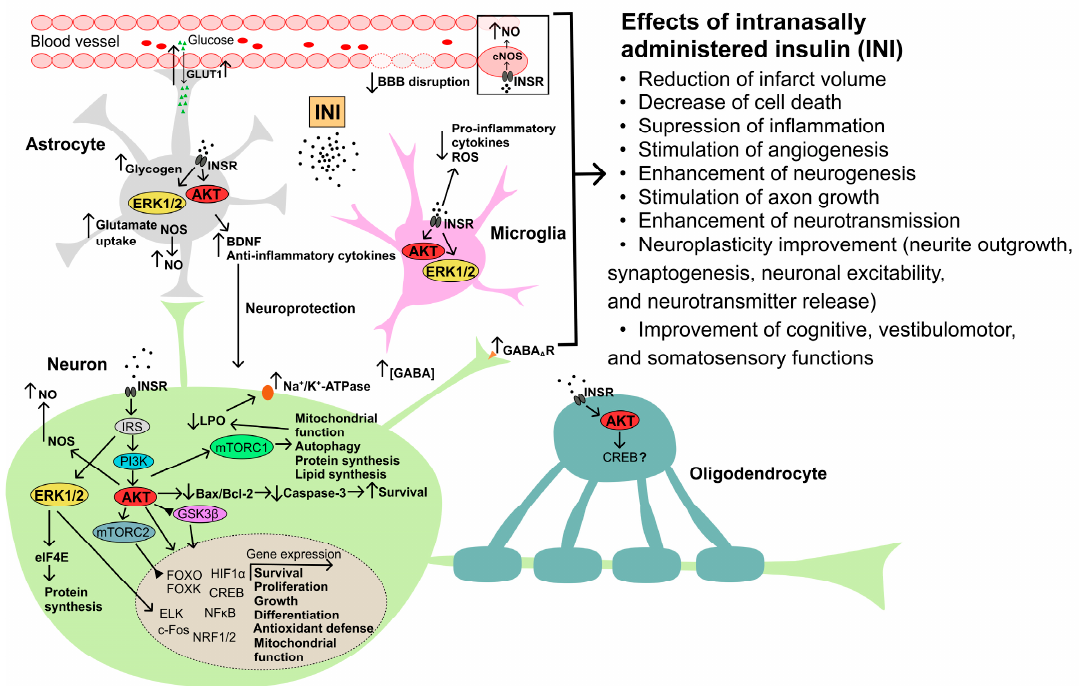
Figure 2. The possible mechanisms of neuroprotective action of intranasally administered insulin in cerebral ischemia and traumatic brain injury. Abbreviations: AKT—AKT kinase; Bax—Bcl-2- associated X protein, proapoptotic factor; BBB—blood–brain barrier; Bcl-2—B-cell lymphoma 2 protein, antiapoptotic factor; BDNF—brain-derived neurotrophic factor; c-Fos—transcription factor of the FOS family; CREB—cAMP response element-binding protein; eIF4E—eukaryotic initiation